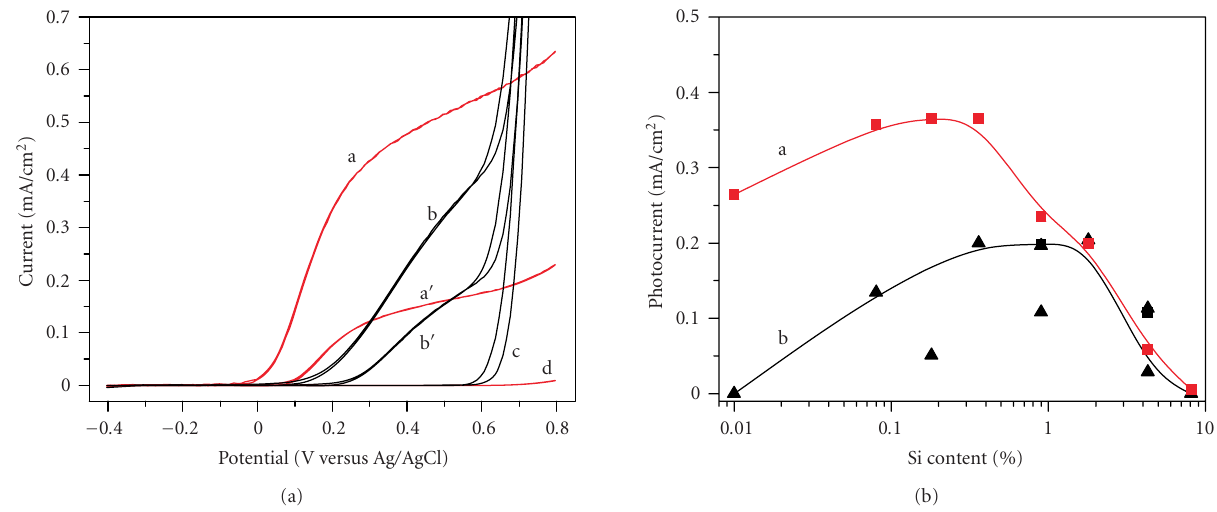
Figure 2: (a) Current-potential measurements under simulated 80 mW/cm 2 AM1.5 sunlight for Fe 2 O 3 doped with 0.2% Si with (a: front- side illumination; a’: back-side illumination; d: dark) and without (b: front-side illumination; b’: back-side illumination; c: dark) 5nm SnO 2 interfacial layer. The scan rate is 20 mV/s. (b) Dependence of the photocurrent (front-side illumination) at 0.23 V versus Ag/AgCl on the Si dopant concentration; a: with SnO 2 interfacial layer; b: without SnO 2 interfacial layer.